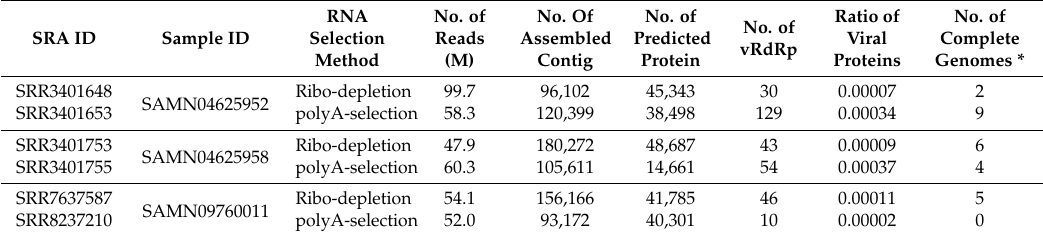
Table 1. Assembly statistics of four viral-metagenomic samples. SRA and sample IDs, RNA selection methods, number of reads in million, and the number of assembled contigs and predicted proteins are reported. The number of viral RNA-dependent-RNA-polymerase (vRdRp) domains, the ratio of viral protein to total proteins, as well as the number of complete viral genomes, are also